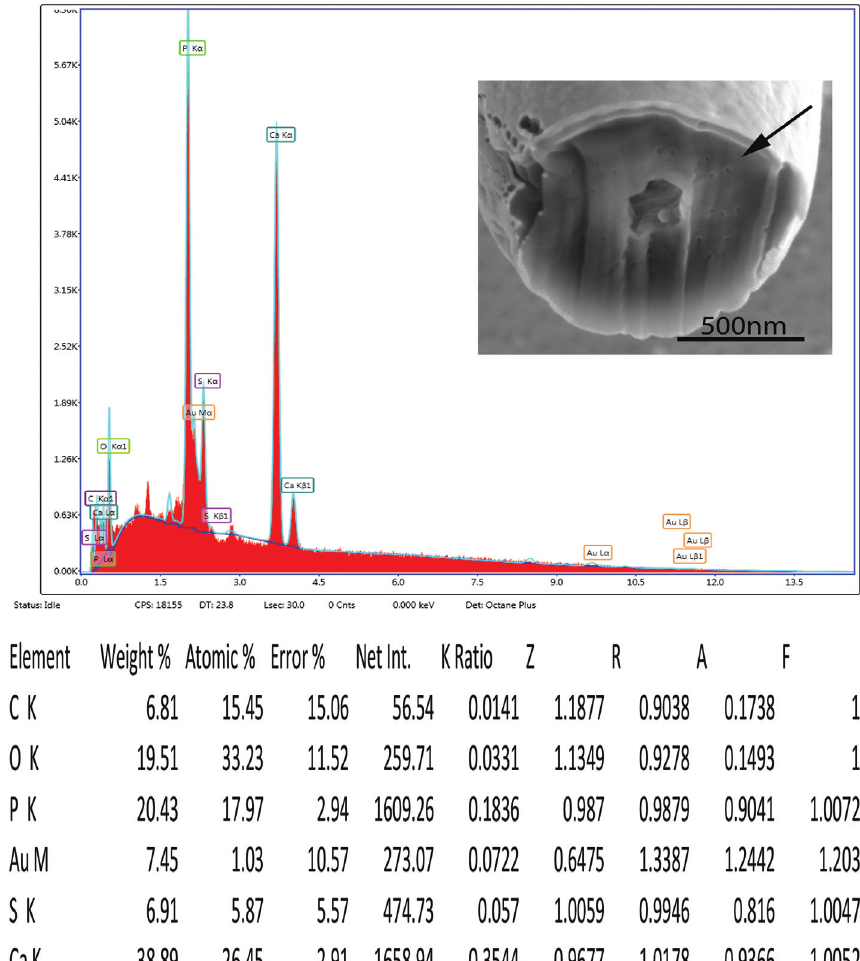
Figure 6. EDAX data for the scan of the edge of a cut hook